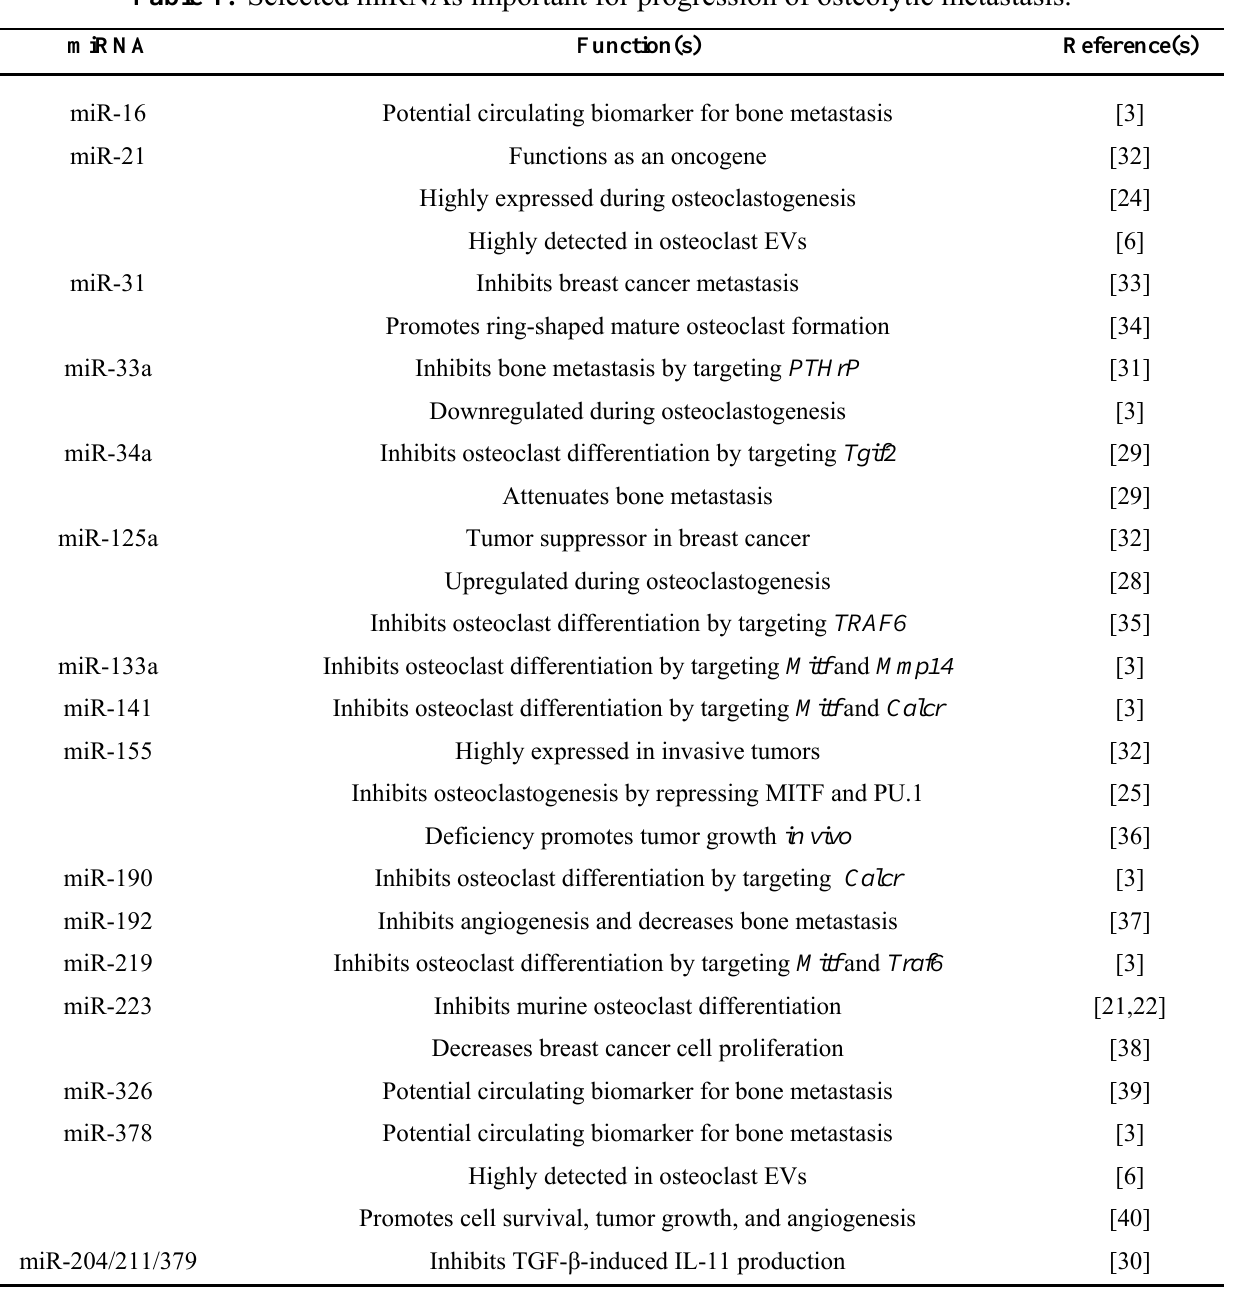
Table 1. Selected miRNAs important for progression of osteolytic